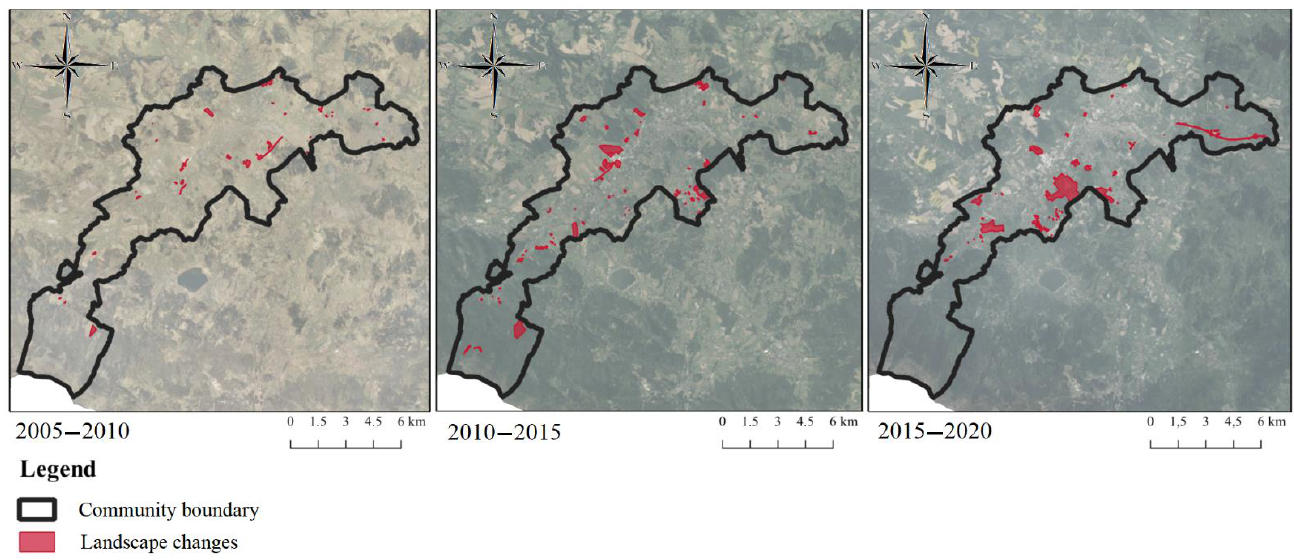
Figure 4. Location of the landscape changes in the city of Jelenia Góra in 2005 – 2010, 2010 – 2015 and 2015 – 2020, respectively.